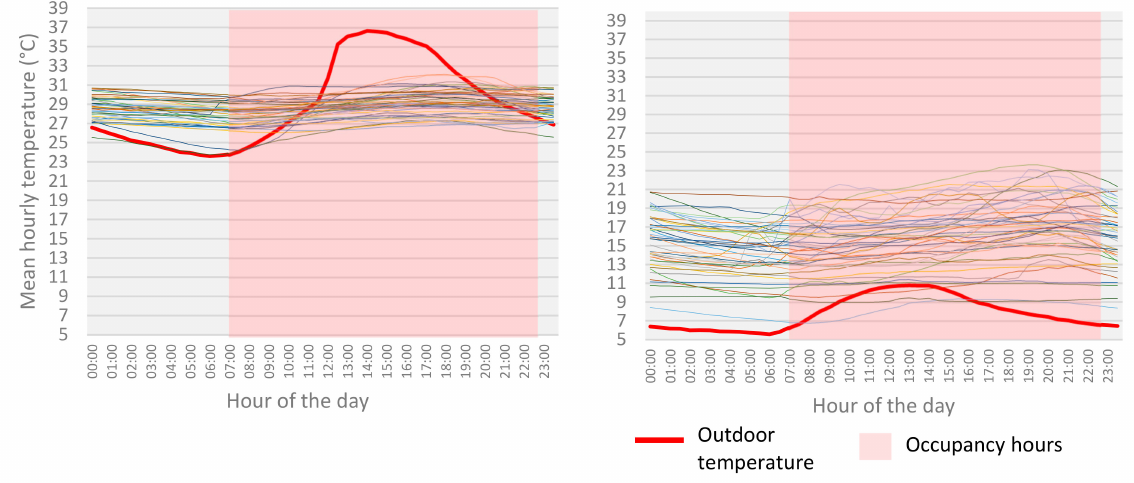
Figure 3. Mean hourly temperatures in living rooms during the summer ( left ) and winter ( right ). (Different colour lines represent the mean hourly temperature of the selected